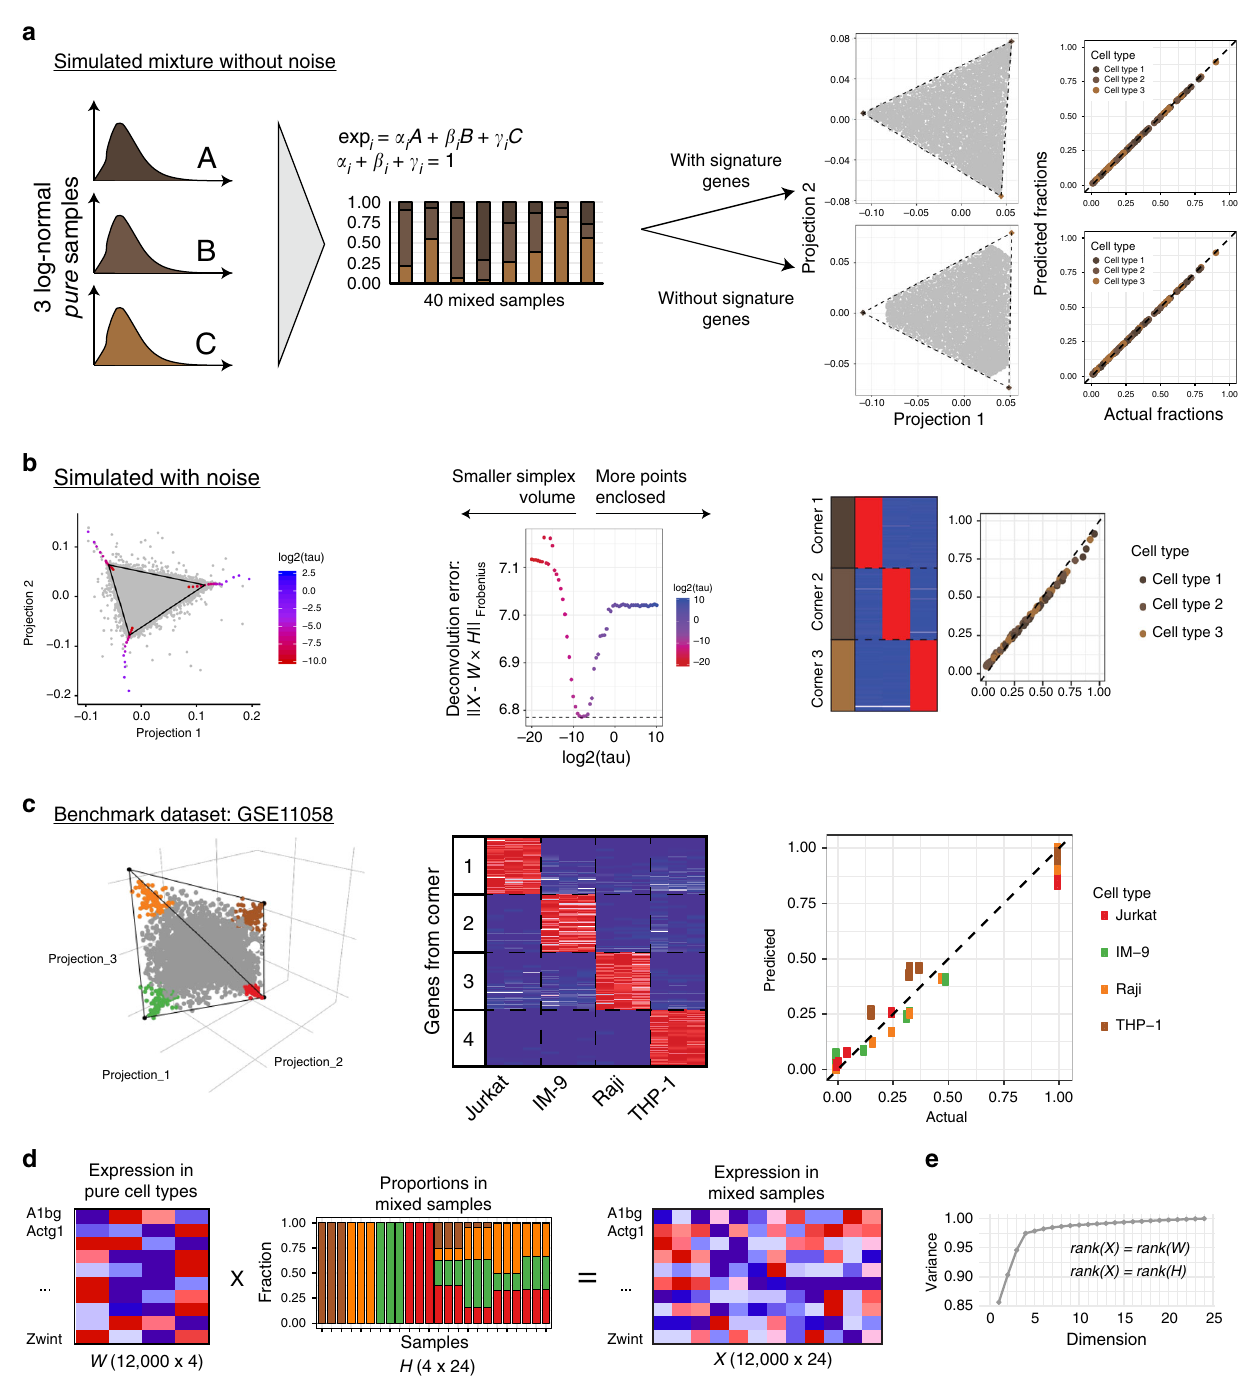
Fig. 4 Geometric algorithms for simplex identi fi cation accurately solve the complete deconvolution problem in benchmark and simulations datasets. a Application of the algorithm to a simulated mixture. Left: dataset design — mixture of three pure samples with log-normally distributed gene expression. Right: Identi fi cation of simplex corners with and without signature genes: SISAL robustly identi fi es corners in both cases. b Dependence of deconvolution accuracy on tolerance level (tau) for simulated data with noise (left and middle). Deconvolution results for best tau (right): heatmap of corner genes expression in pure cell types and comparison of actual versus estimated cell fractions. c Application of algorithm to benchmark dataset GSE11058: identi fi ed simplex has a form of tetrahedron (4-simplex), heatmap shows cell-speci fi c expression of corner genes and dot plot shows concordance between actual and estimated fractions of cell types. d Schematic for linear model for dataset GSE11058. e Variance explained by each SVD component for benchmark dataset GSE11058. Expression levels in heatmaps in panel b and c are from 0 (blue) to gene max